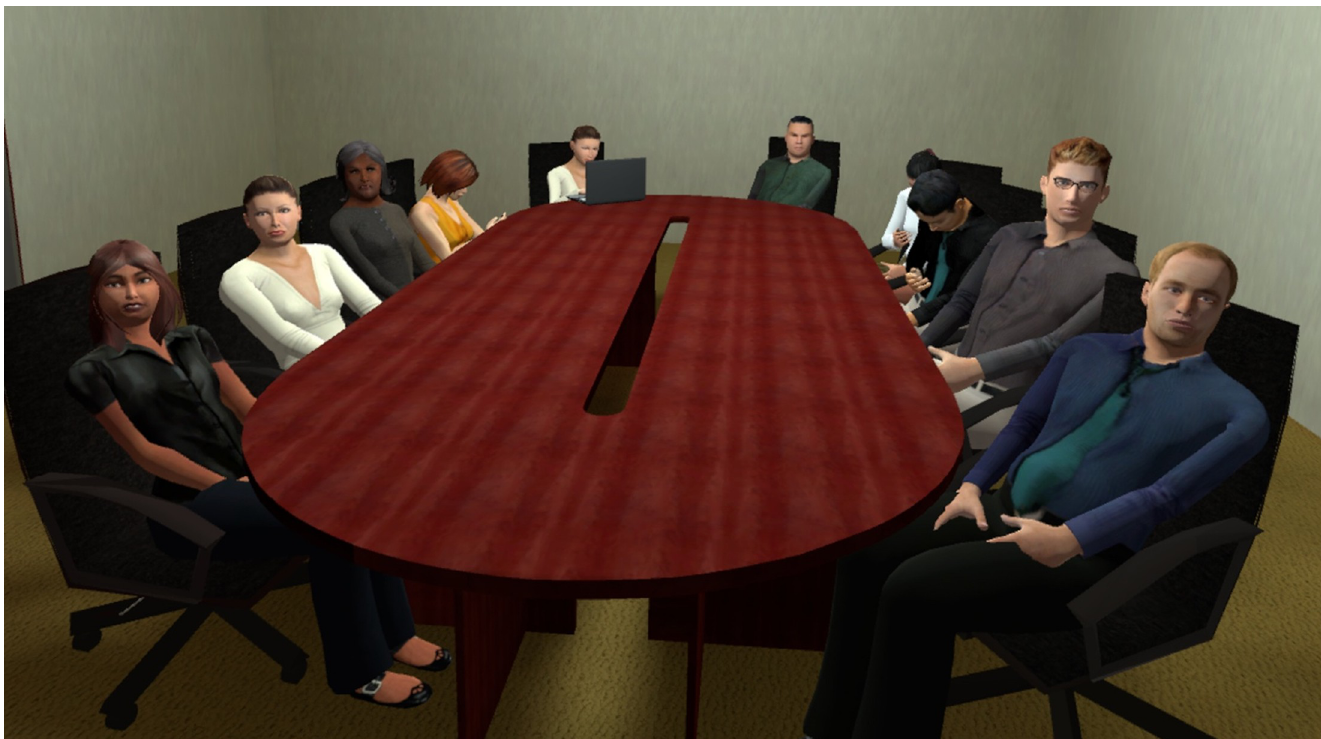
Fig 3. Example of large room